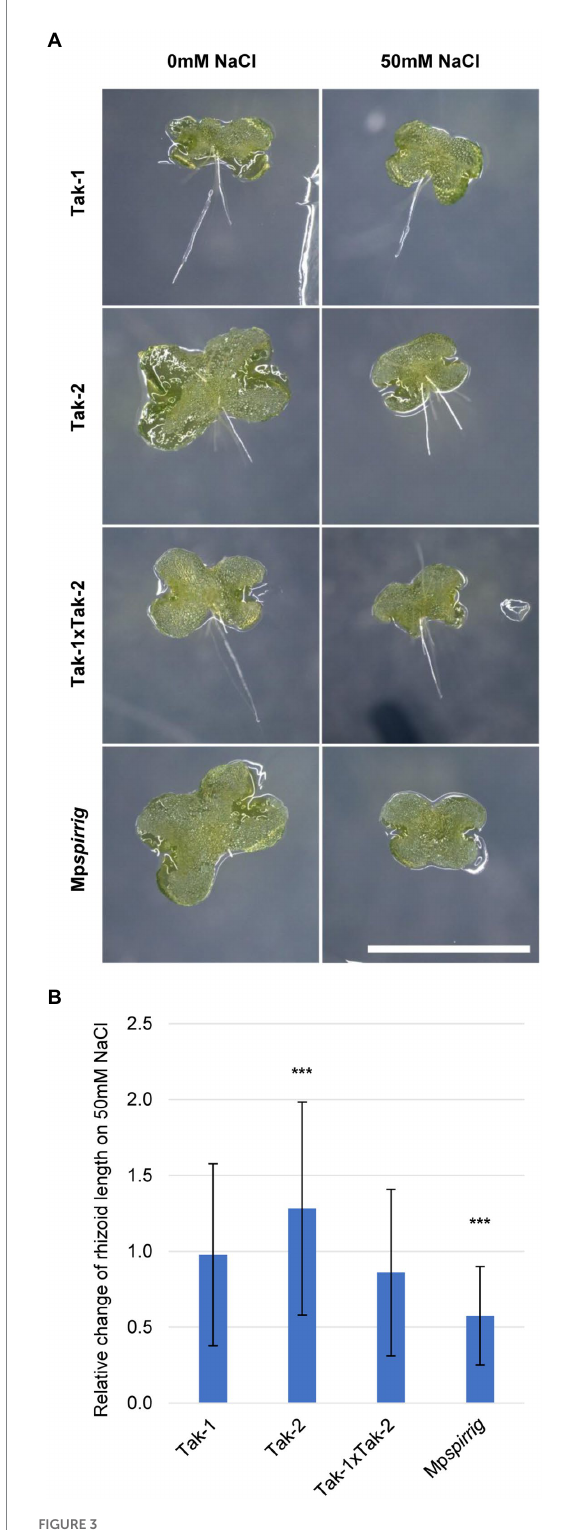
FIGURE 3 Mp spirrig is salt hypersensitive. (A) Rhizoid growth is strongly impaired in 4-day-old gemmalings of Mp spirrig compared to Tak-1, Tak-2, and Tak1xTak-2. Scale bar: 2 mm. (B) Comparison of rhizoid growth under salt stress ( n ≥ 160) and control conditions ( n ≥ 240) on 7-day-old gemmalings. Significance was tested by ANOVA at p ≤ 0.001 ( ***